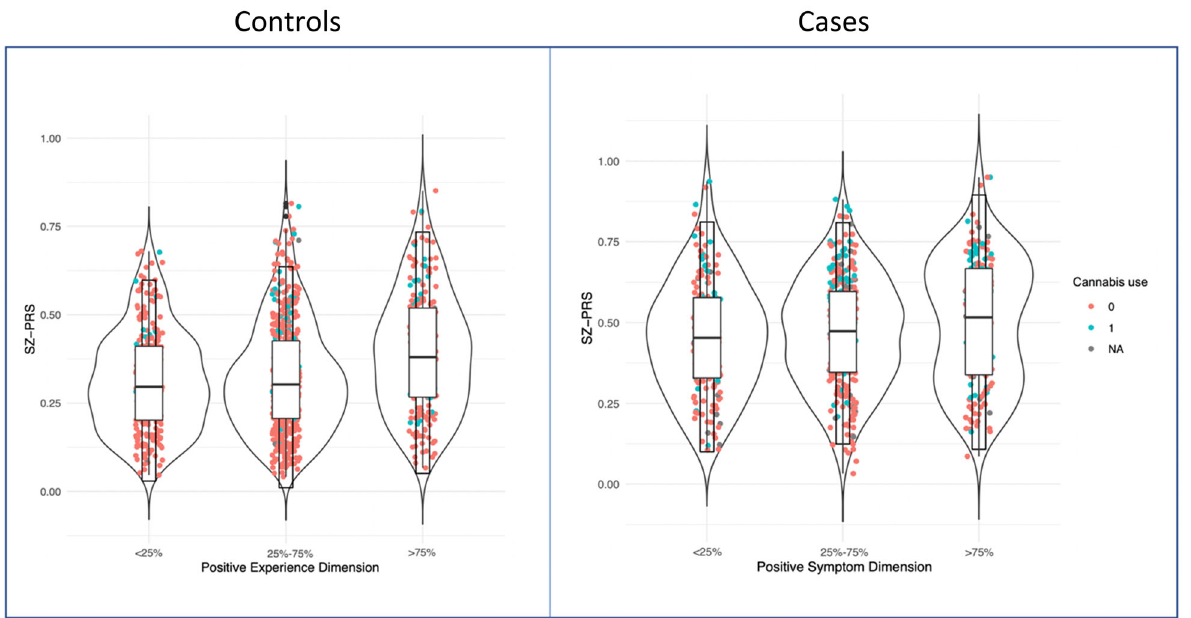
Fig. 1 Quantiles of psychosis dimensions in the general population and separately in FEP patients by SZ-PRS. The violin plots show the distribution of SZ-PRS in the EU-GEI sample by individuals classi fi ed according to their score at the positive experience and symptom dimensions, separately in population controls (left side) and FEP patients (right side) at different quantiles (0 – 25% psychotic experiences or symptoms; 25 – 75% psychotic experiences or symptoms; 75 – 100% psychotic experiences or symptoms). Explanatory note: Interquartile range, 95% con fi dence interval, median and mean are illustrated within the bars. The shape on each side of the bars represents the density distribution. Dots indicate current cannabis use in controls and daily cannabis use in patients (red = no; green = yes). Table 3. Psychotic experience dimension scores by SZ-PRS in controls.